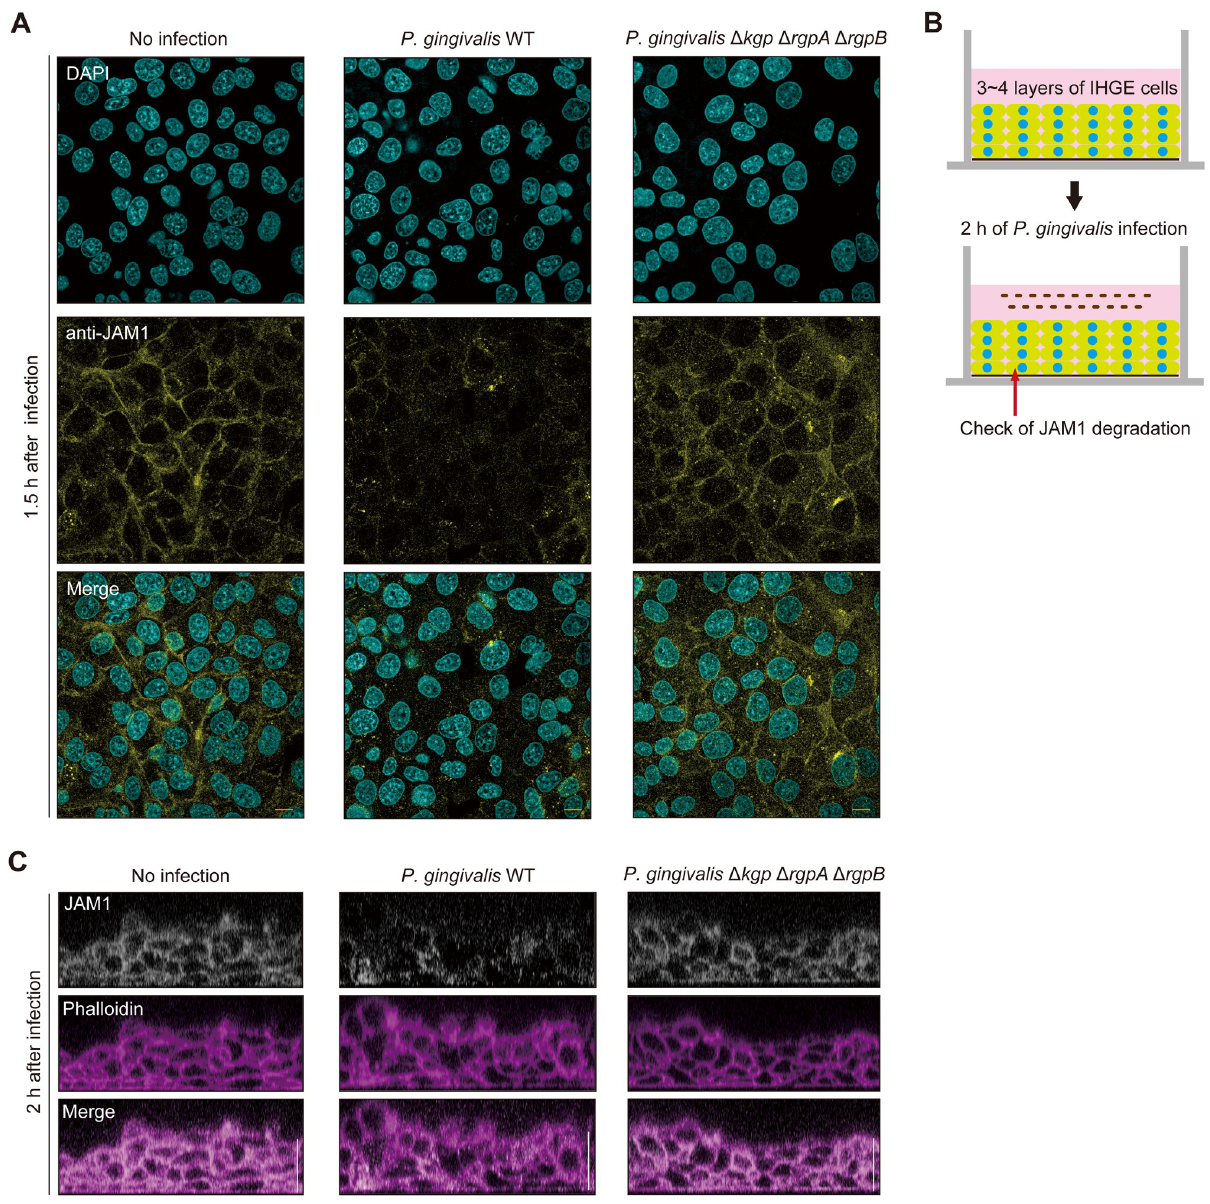
Fig 2. Confocal microscopic images of JAM1 in IHGE cells infected with P . gingivalis WT or the Δ kgp Δ rgpA Δ rgpB mutant. (A) IHGE cells were infected with P . gingivalis WT or the Δ kgp Δ rgpA Δ rgpB mutant at an MOI of 100 for 1.5 h. The cells were then fixed, stained with DAPI (cyan) and anti-JAM1 (yellow), and analyzed by confocal microscopy. Scale bars, 10 μ m. ( B, C) Schematic illustration (B) and confocal microscopic cross-sectional images (C) of the 3D-tissue model of IHGE cells. Gingival epithelial tissues on coverslips were infected with P . gingivalis WT or the Δ kgp Δ rgpA Δ rgpB mutant for 2 h. The tissues were then fixed, stained with anti-JAM1 (white) and Alexa Fluor 568–conjugated phalloidin (magenta), and analyzed by confocal microscopy. Scale bars, 30 μ m. membrane protein) or EGFP-TOMM20 (marker for outer mitochondrial membrane protein; not included in endomembrane system), and determined the co-localization of HA-inserted JAM1 and the organelle marker by confocal microscopy. The mCherry and anti-HA signals co-localized with SEC61 β (Fig 3C, 3D and S9A–S9F Fig), but not TOMM20 (S10A–S10D Fig), suggesting that JAM1 transport is mediated by an endomembrane system. Notably, actin